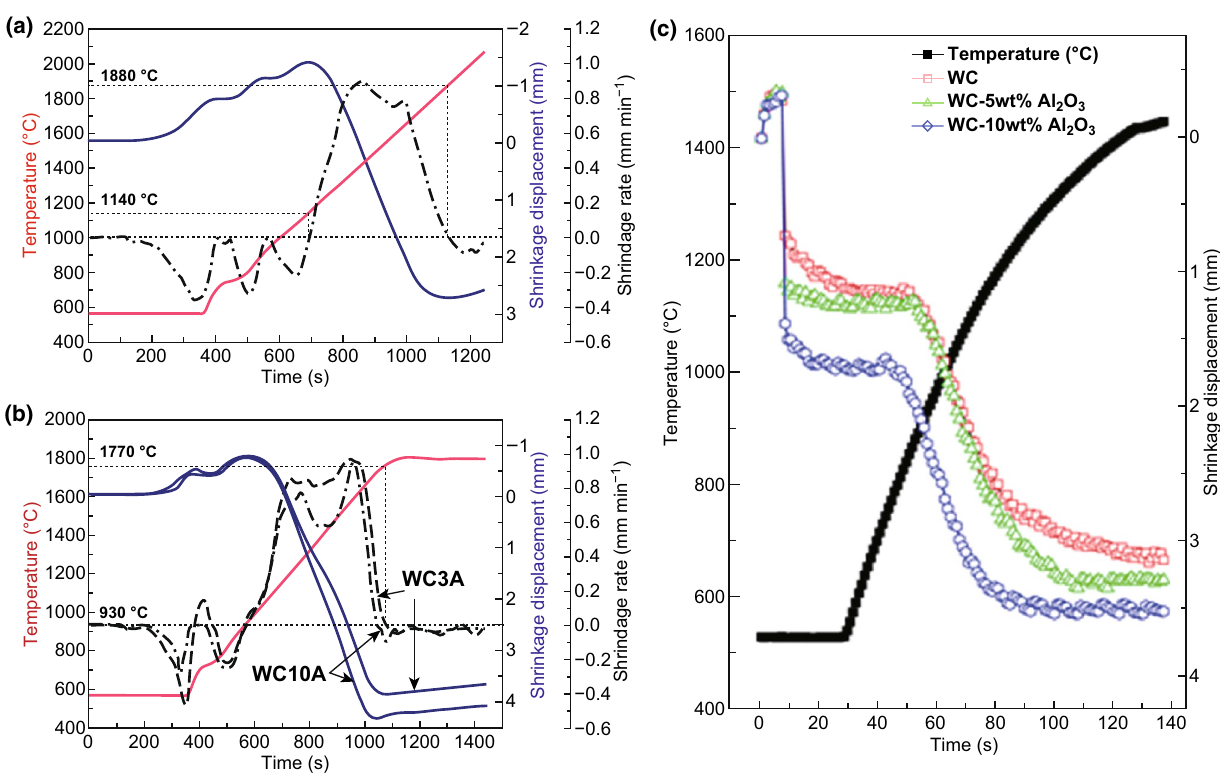
Fig. 6 Densification behavior of a WC, SPSed at 2060 °C for 0 min, and b WC3A (WC–3 wt% Al 2 O 3 ) and WC10A (WC–10 wt% Al 2 O 3 ), SPSed at 1800 °C for 5 min [99]. c Variations of temperature and shrinkage with heating time during the pulsed current activated sintering of WC–Al 2 O 3 powder [100]. Figure panels reproduced from Ref. [99] with permission from Elsevier copyright 2012, Ref. [100] with permission from Elsevier copyright 2016